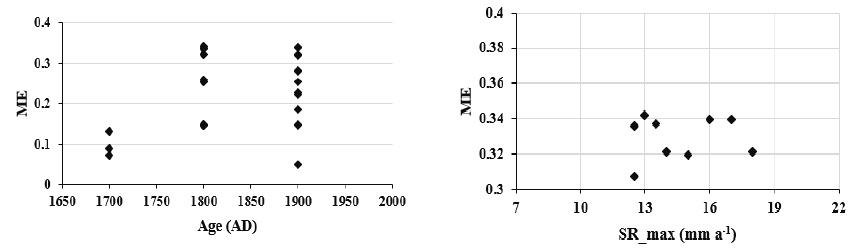
Figure 15. Model efficiency for several scenarios as a function of the start of first sedimentation rate (SR) increase, and height of the SR for Dembelle floodplain .